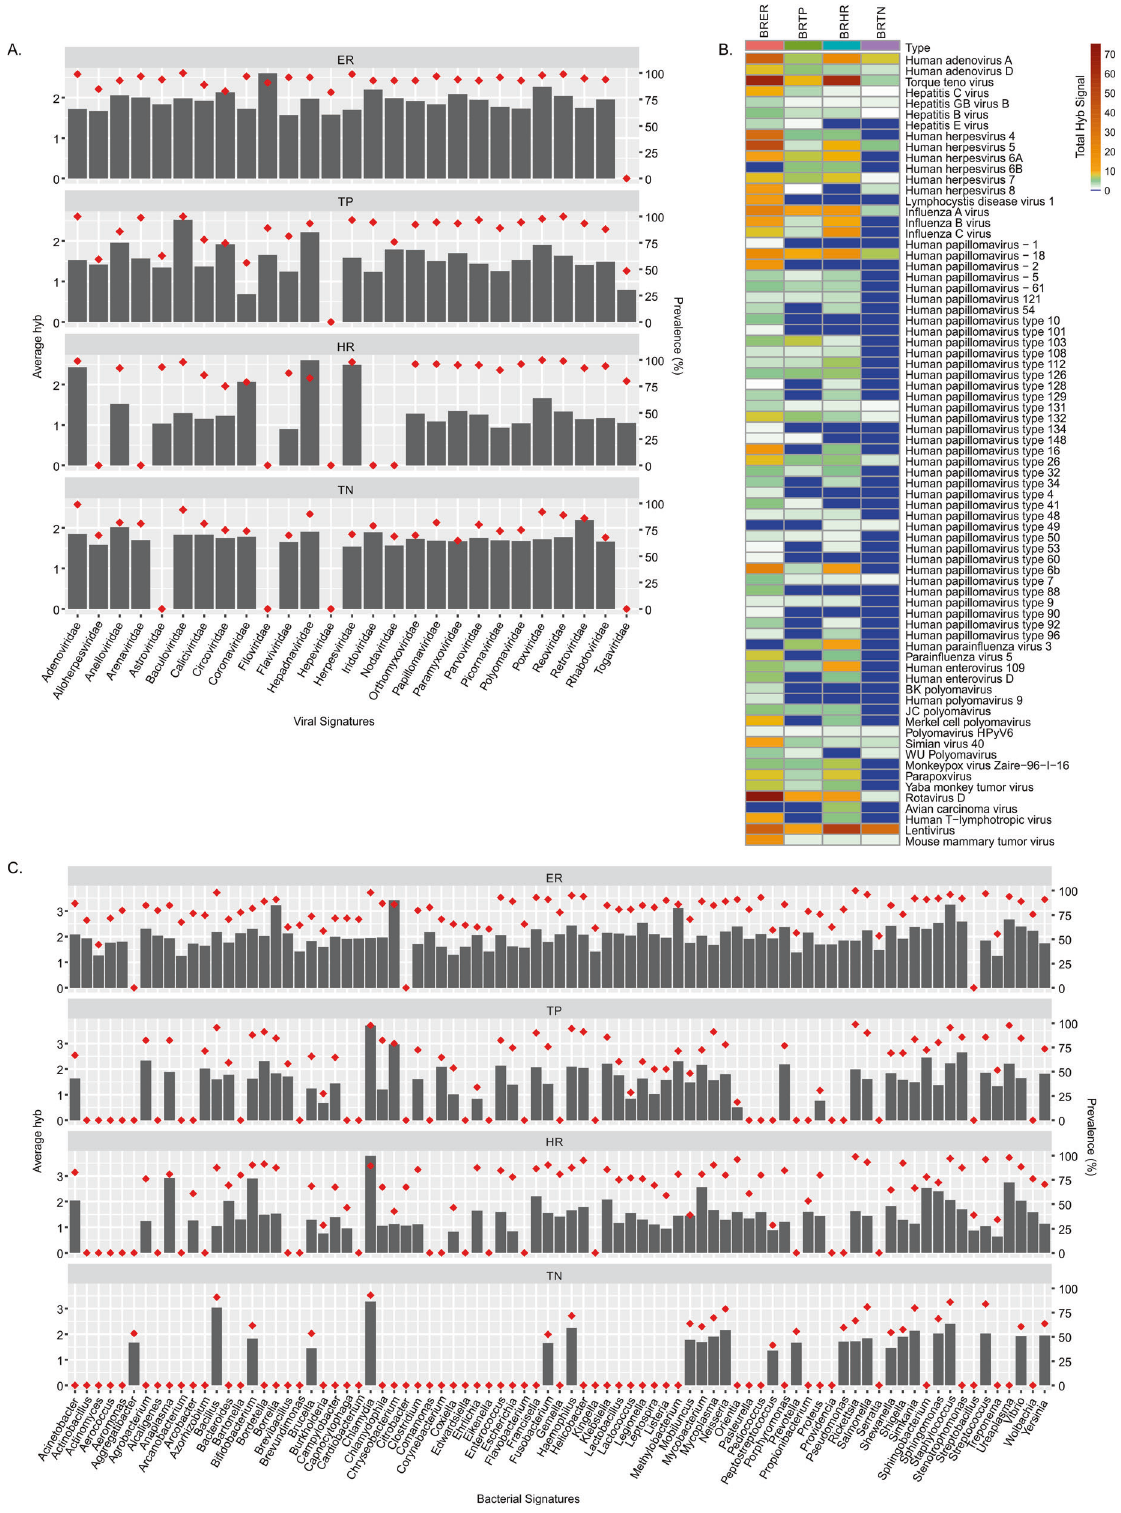
Fig. 2 Viral and bacterial microbial signatures detected in the four types of breast cancers. A , C The bars represent the average hybridization signal for each virus and bacterial signatures respectively, while the percent prevalence of those virus and bacterial signatures in the sample set is indicated by the red dots. B The average hybridization signals for speci fi c viruses were summed and represented as heatmap to show low to high detections of speci fi c viral signatures in the four types of breast